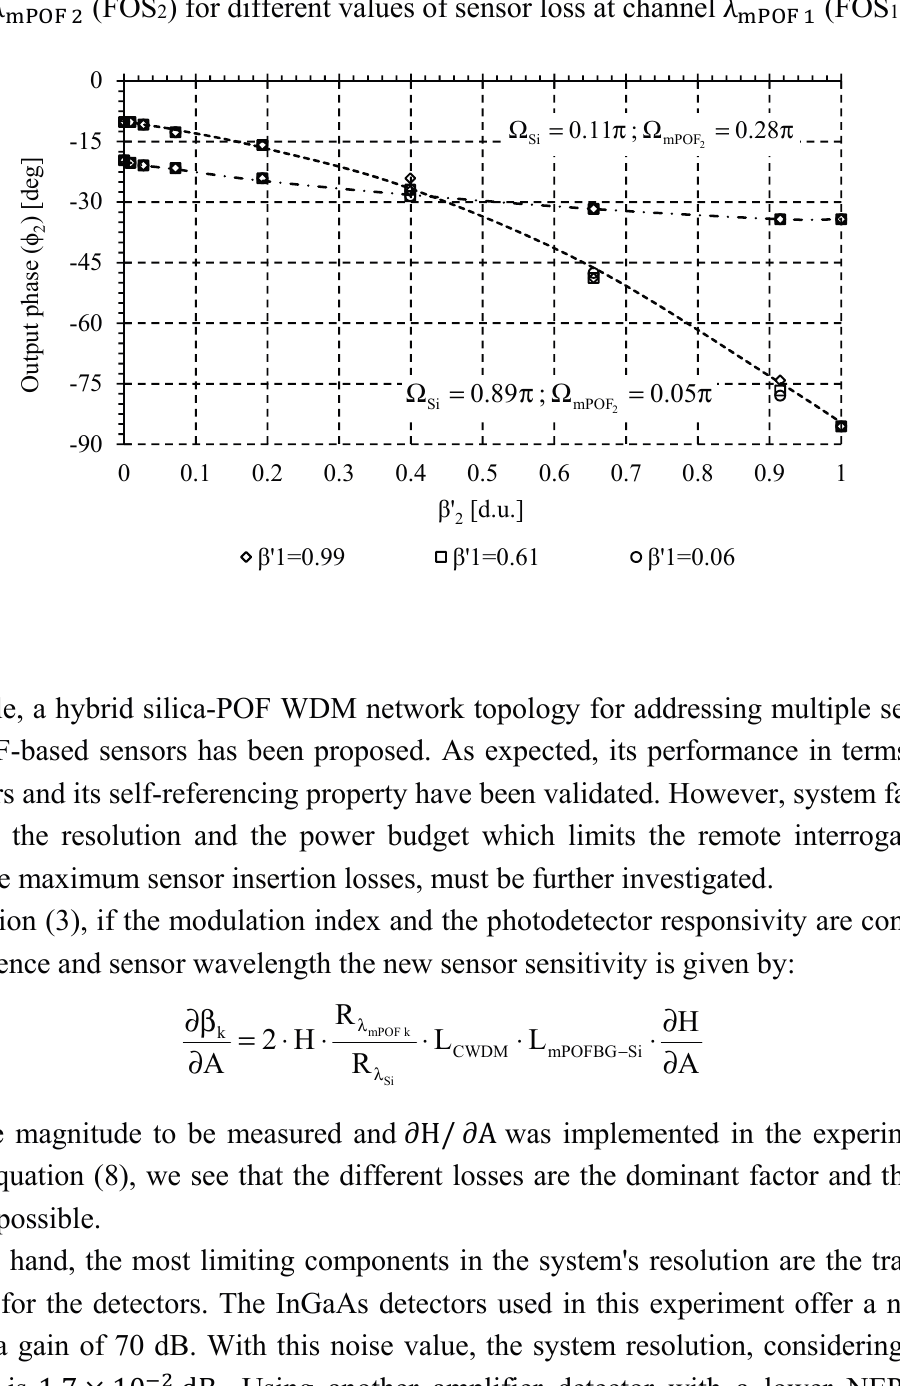
(FOS 1 (cid:2923)(cid:2900)(cid:2899)(cid:2890) (cid:2869)